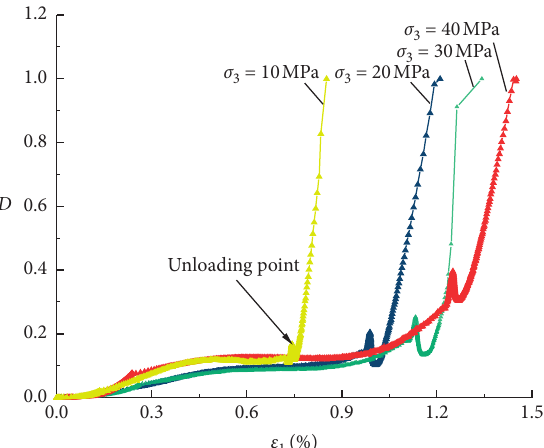
Figure 13: Damage evolution characteristics of sandstone unloading under different initial confining